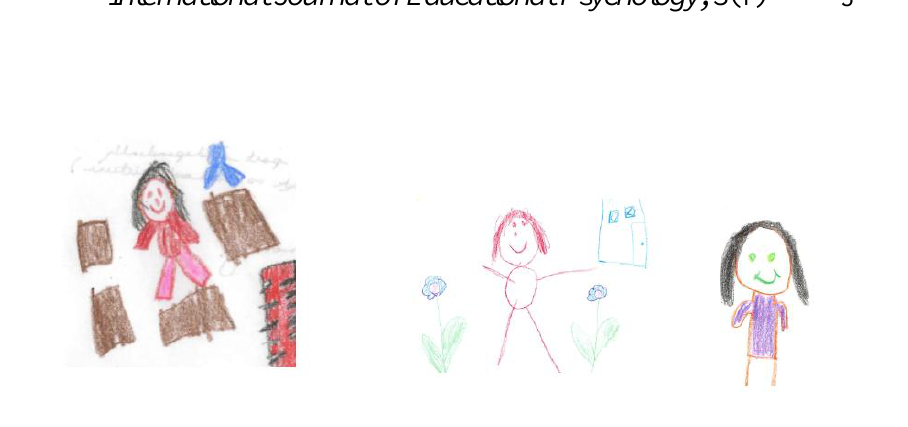
Figure 1. Gabby’s self portraits at ages 5, 7, and 9.